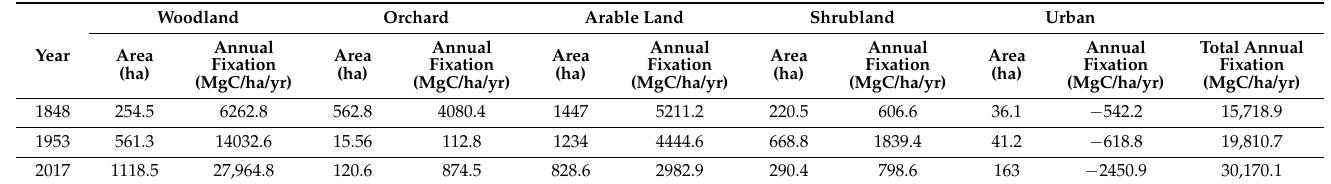
Table 2. Annual balance of CO 2 in the study